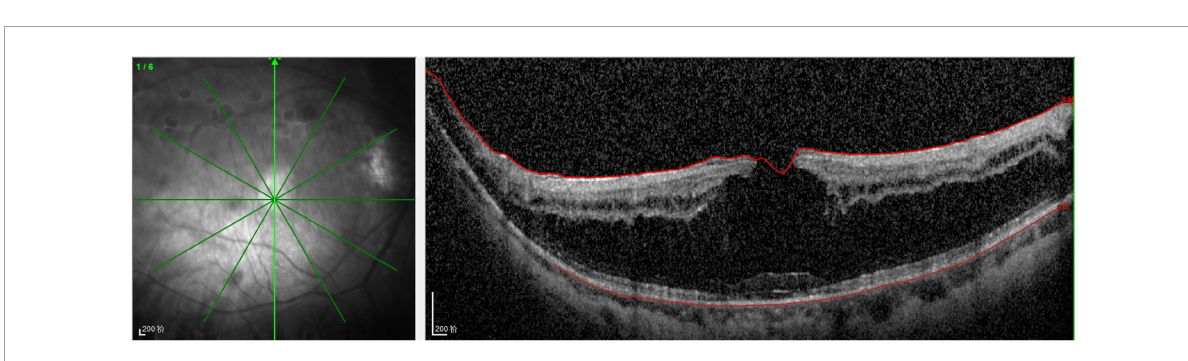
FIGURE3 Spectral-domain optical coherence tomography (SD-OCT) revealed the lamellar macular hole and retinoschisis in her right